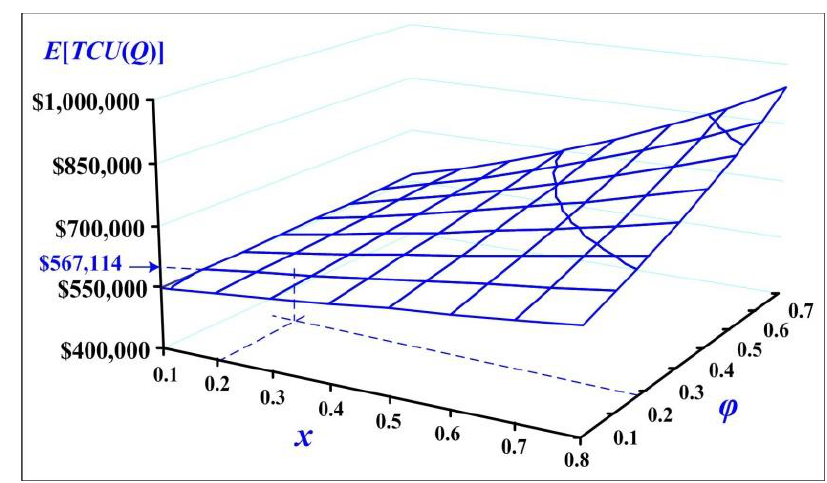
Figure 6. Joint effects of nonconforming rate x and overall scrap rate φ on E [ TCU ( Q )]